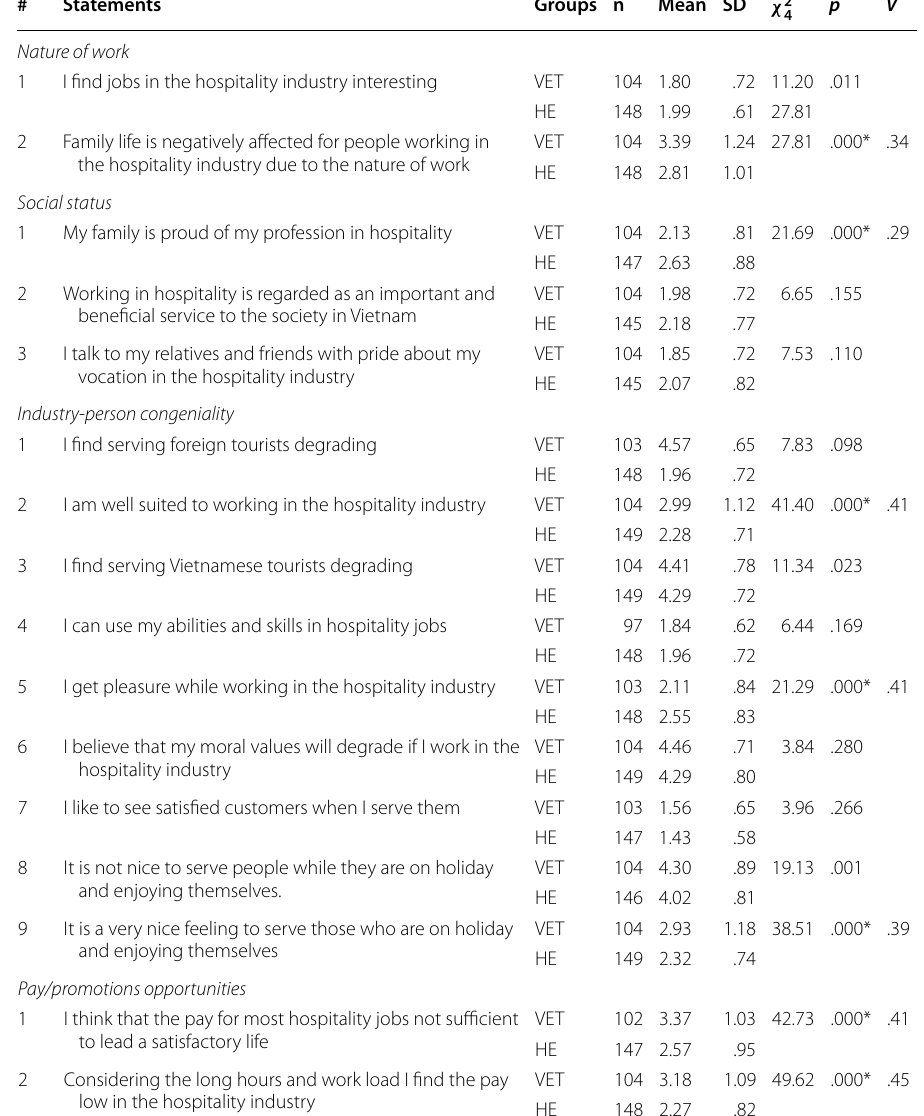
Table 7 Summary of survey responses, showing average agreement (from 1: strongly agree, to 5: strongly disagree) across seven dimensions by student